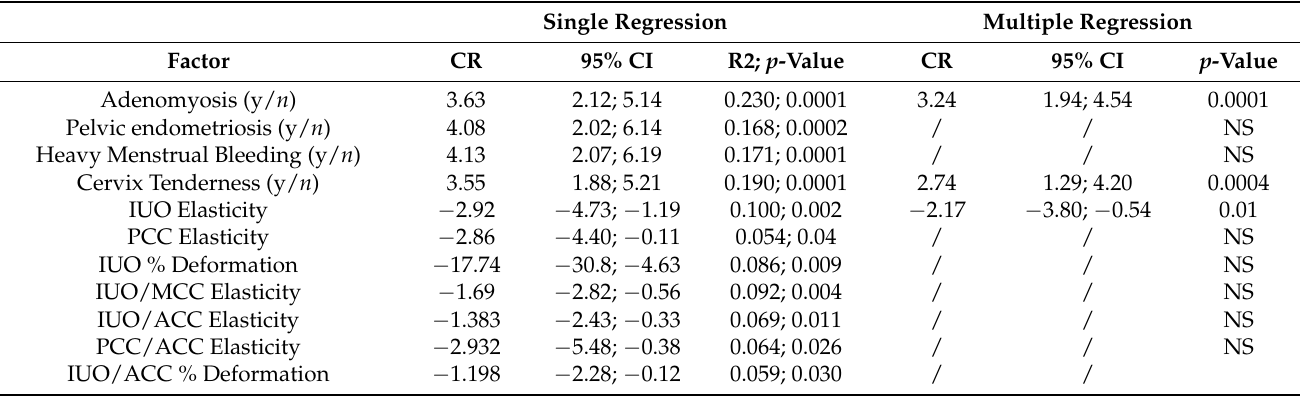
CR = coefficient of regression; CI = confidence Interval; ACC = anterior cervical compartment; PCC = Posterior cervical compartment; IUO = internal uterine orifice; MCC = middle cervical canal. y/n = yes/no; NS = not